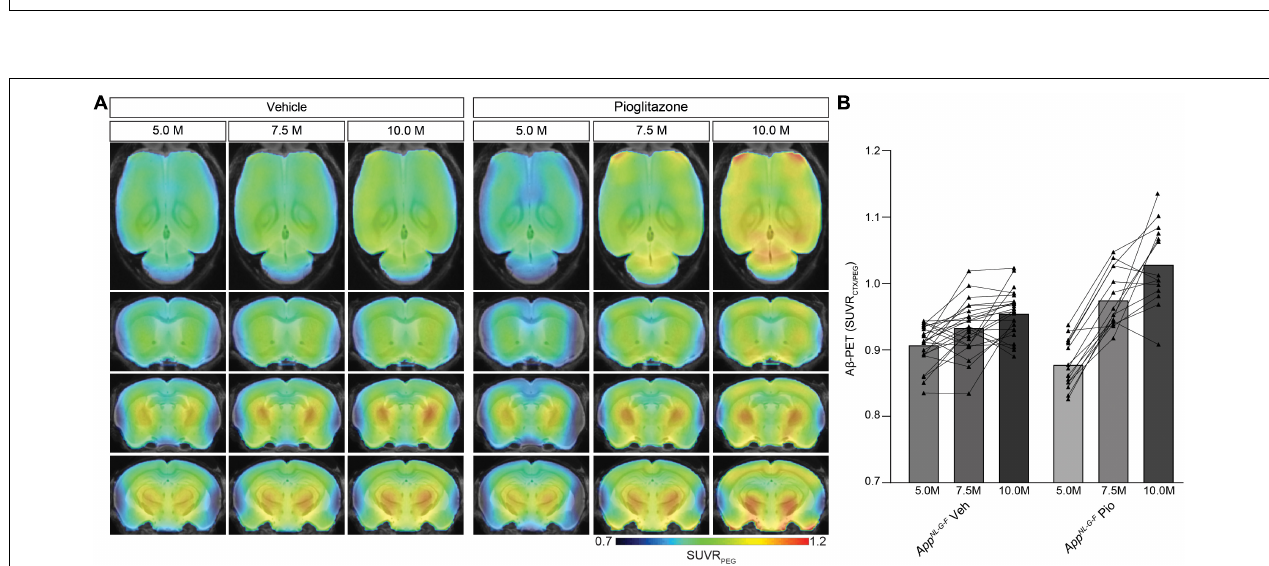
FIGURE 2 | Distinct A β -PET signal increase upon PPAR γ stimulation in App NL - G - F mice with limited plaque fibrillarity and without overexpression of APP. (A) Regional analysis of group-averaged standardized uptake value ratios (SUVR) of the A β -PET radiotracer [ 18 F]florbetaben in untreated and in pioglitazone treated App NL - G - F animals at the age of 5, 7.5, and 10 months. Coronal and axial slices are projected upon a standard MRI template. (B) Plots show cortical SUVR of [ 18 F]florbetaben in App NL - G - F mice between the age of 5 and 10 months under vehicle or pioglitazone treatment. A β -PET signal increased in untreated mice during age but the increase was more pronounced in pioglitazone treated App NL - G - F mice [ F ( 2 , 70 ) = 20.12; p < 0.0001]. Data are presented as mean ± SEM. P -values of Bonferroni post-hoc test result from two-way ANOVA. N = 14–23.